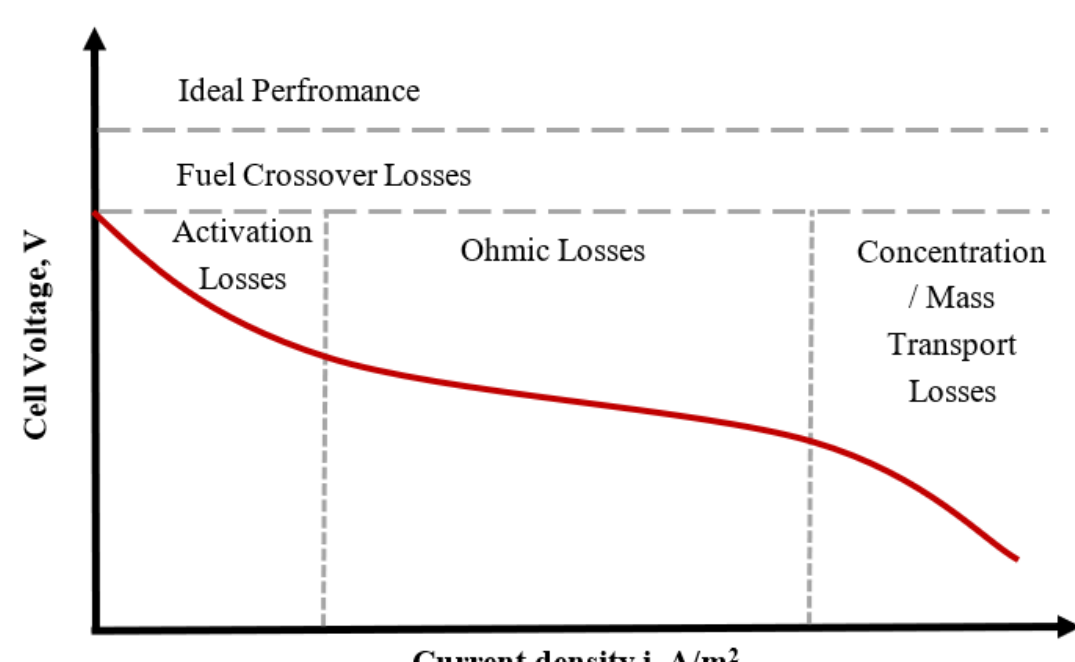
Figure 1. Polarization curve with the electric losses’ regions encountered with the operation of PEMFC (adapted from [28] (license no. 5172430728078)).